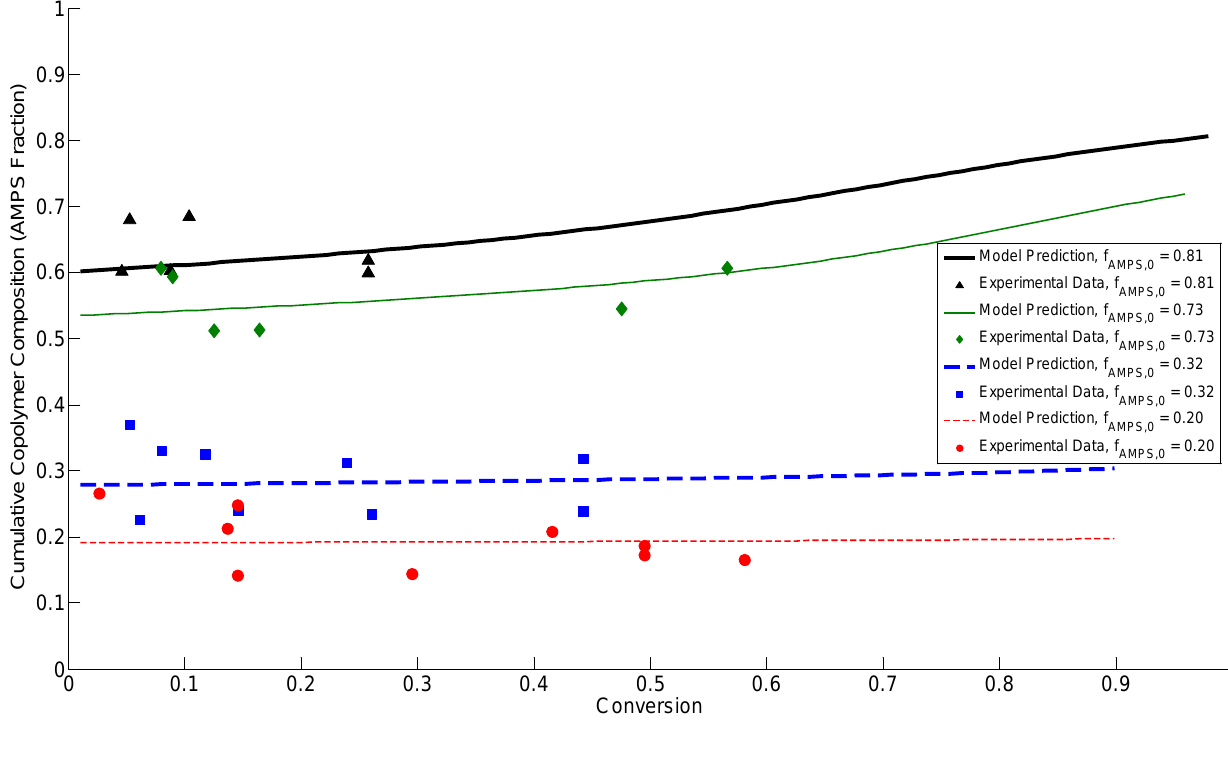
Figure 6. Cumulative copolymer composition for